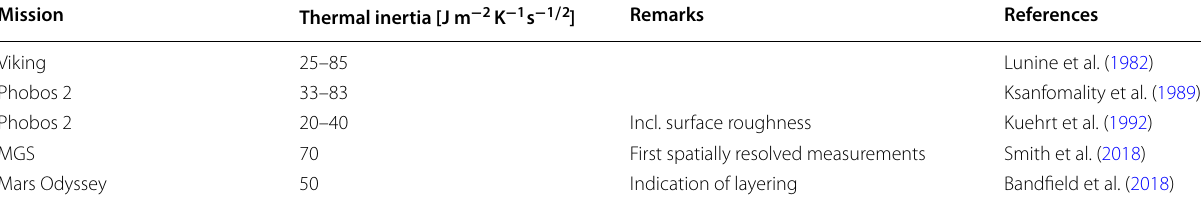
Table 2 Estimates of Phobos’ thermal inertia